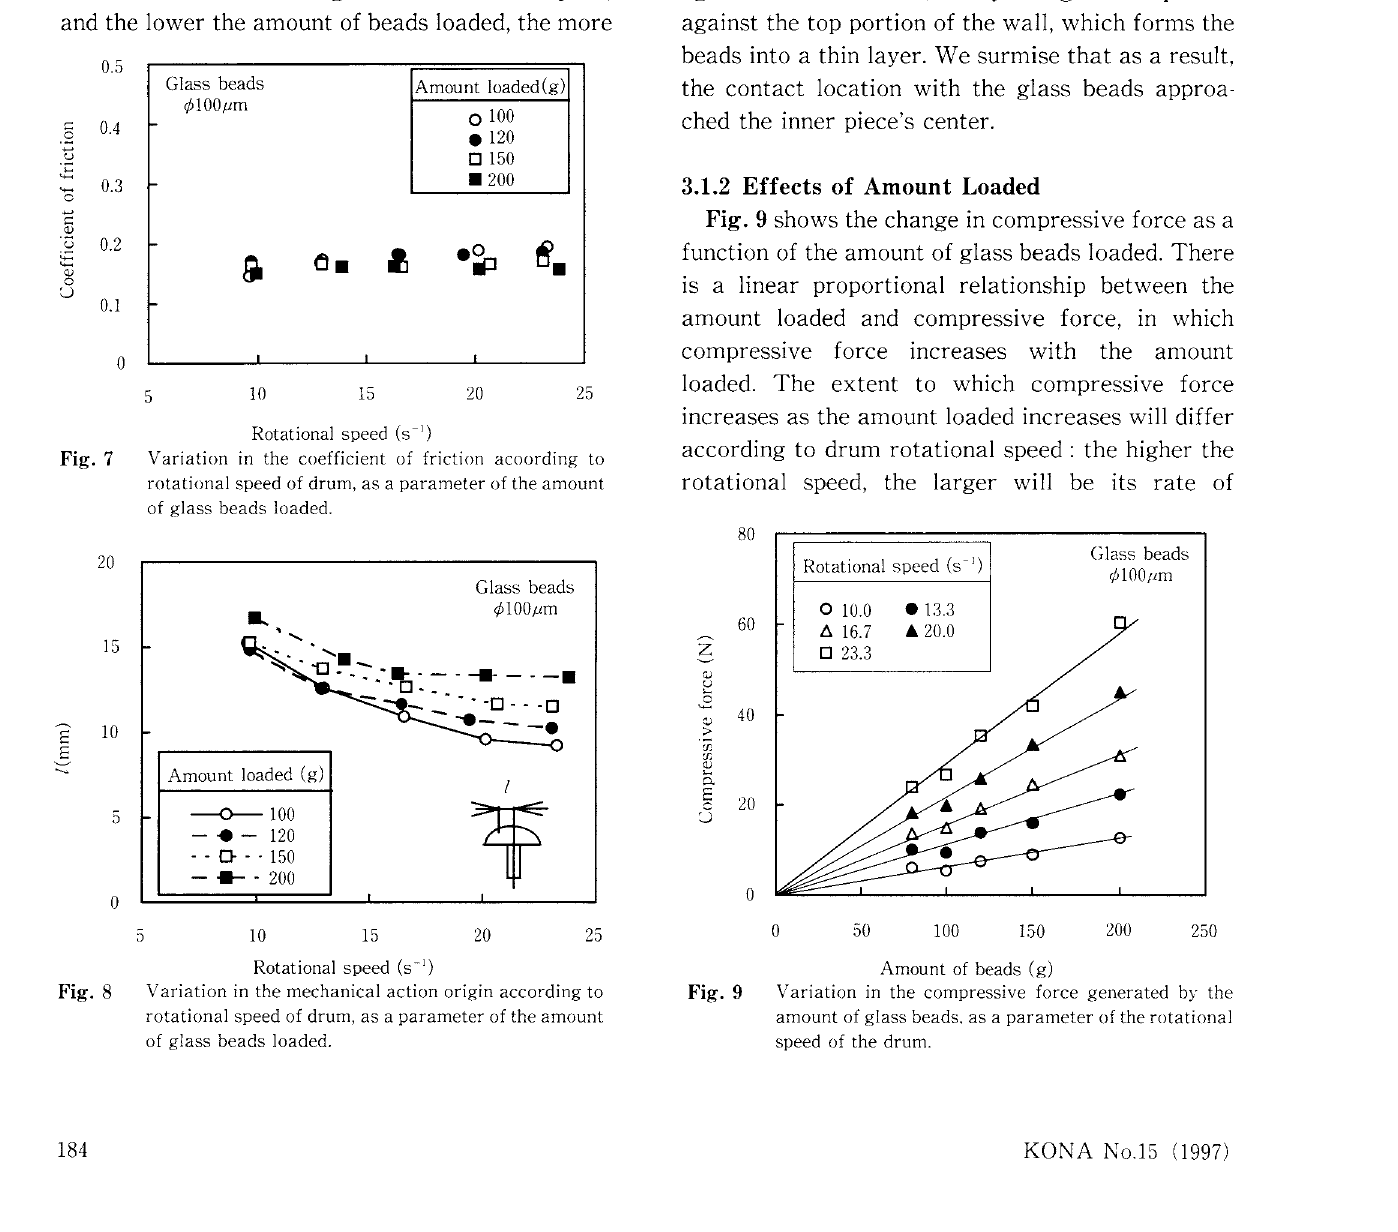
Variation in the compressive force generated by the amount of glass beads. as a parameter of the rotational speed of the